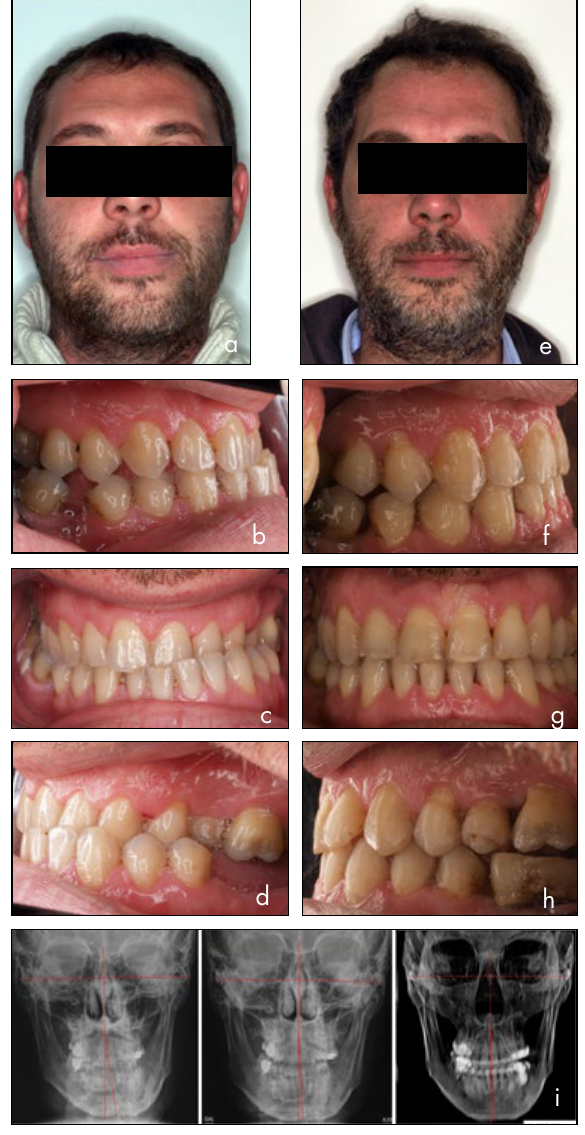
Figure 6. (a–d) A forty-six-year-old female patient demonstrating skeletal asymmetry with a deviation of the chin to the left. The lower dental midline deviated 4 mm to the left leading to a Class II canine relation on the left side. (e–h) The patient had the mandible repositioned to the right. The crowns of the right canine and premolar were modified and an implant replaced the upper right second premolar. Orthodontic treatment also included expansion of the left lower segment in order to maintain occlusal contacts in the new mandibular position. At two years follow-up, facial symmetry was greatly improved, the dental midlines were coincident and a canine Class I was present on the left side. Prosthetic rehabilitation was still to be completed. (i) Posteroanterior radiograph illustrating the changes that occurred in the frontal plane.